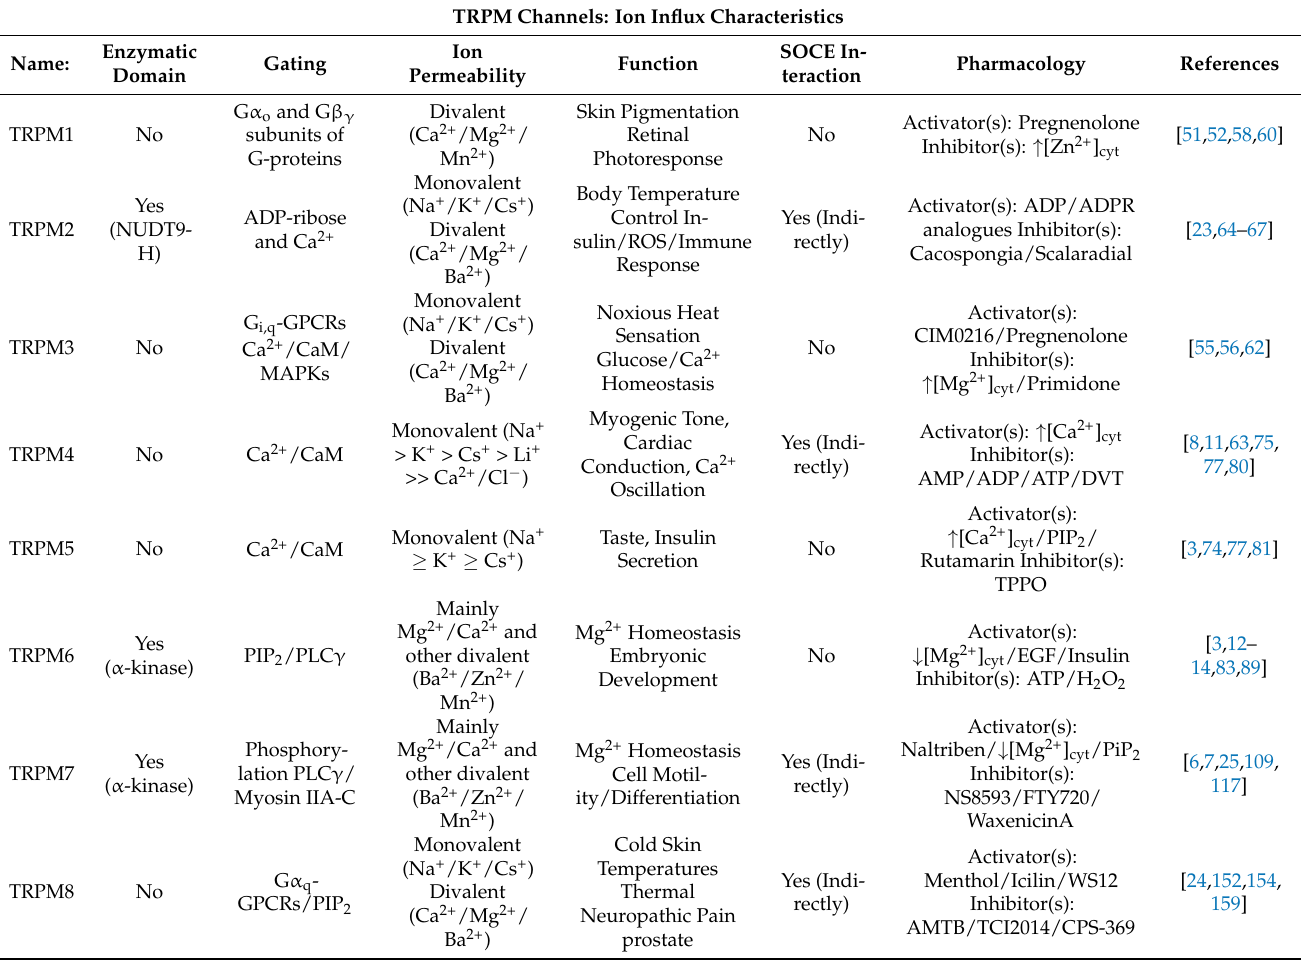
Table 1. TRPM1-8 channels ion influx characteristics including, enzymatic domain, gating, ion permeability, function, SOCE interaction and